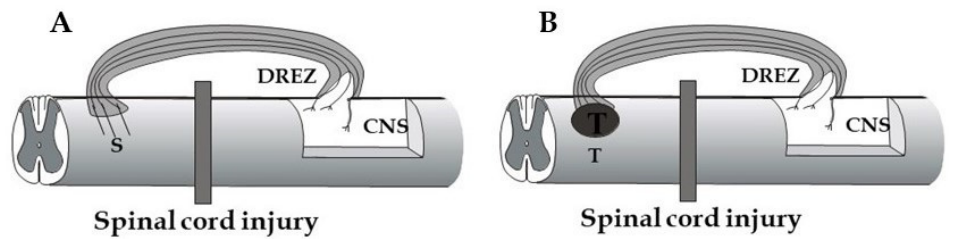
Figure 5. Principle scheme to use the DREZ as an entry point for axons growing in a bridge circum- venting a spinal cord injury. ( A ) Axons from injured descending pathways (S) grow into and within a peripheral nerve graft (or biomimetic conduit) and may be able to enter the spinal cord through the intact or drug/cell modified DREZ. ( B ) Axons from an intraspinal transplant (T) grow through the bridge and may, because of their immaturity, be able to grow through the intact or reactive DREZ.